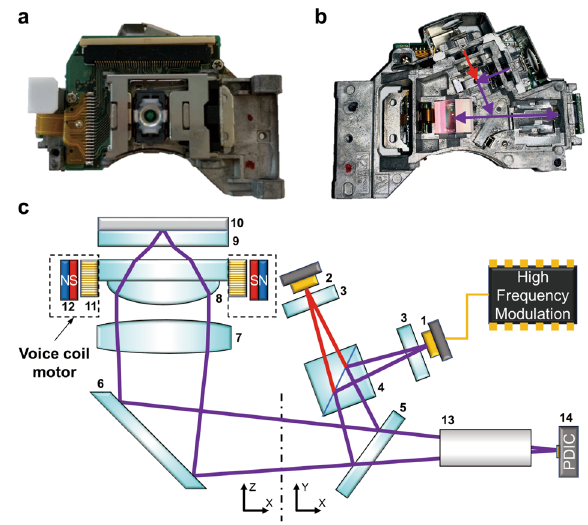
Fig. 1 High-de fi nition digital versatile discs (HD DVDs) optical-pickup- unit (OPU) for 3D printing using photopolymerization. Photograph of HD DVDs OPU from a top view and b bottom view (the purple and red arrows indicate the optical path of 405 nm and 650/780 nm laser, respectively). c Intrinsic optical module, sensors, and actuators. 1: 405 nm laser diode, 2: splitter, 5: beam splitter, 6: fold mirror, 7: collimating lens, 8: objective lens, 9: protective layer, 10: CD/DVD/HD-DVD disc data layer, 11: coil, 12: magnet, 13: expanding lens and 14: photodiode integrated circuit (PDIC). (The purple line represents 405 nm laser, while the red line represents 650/780 nm laser. Dot-dashed line indicates the transformation of view direction between XY panel and XZ